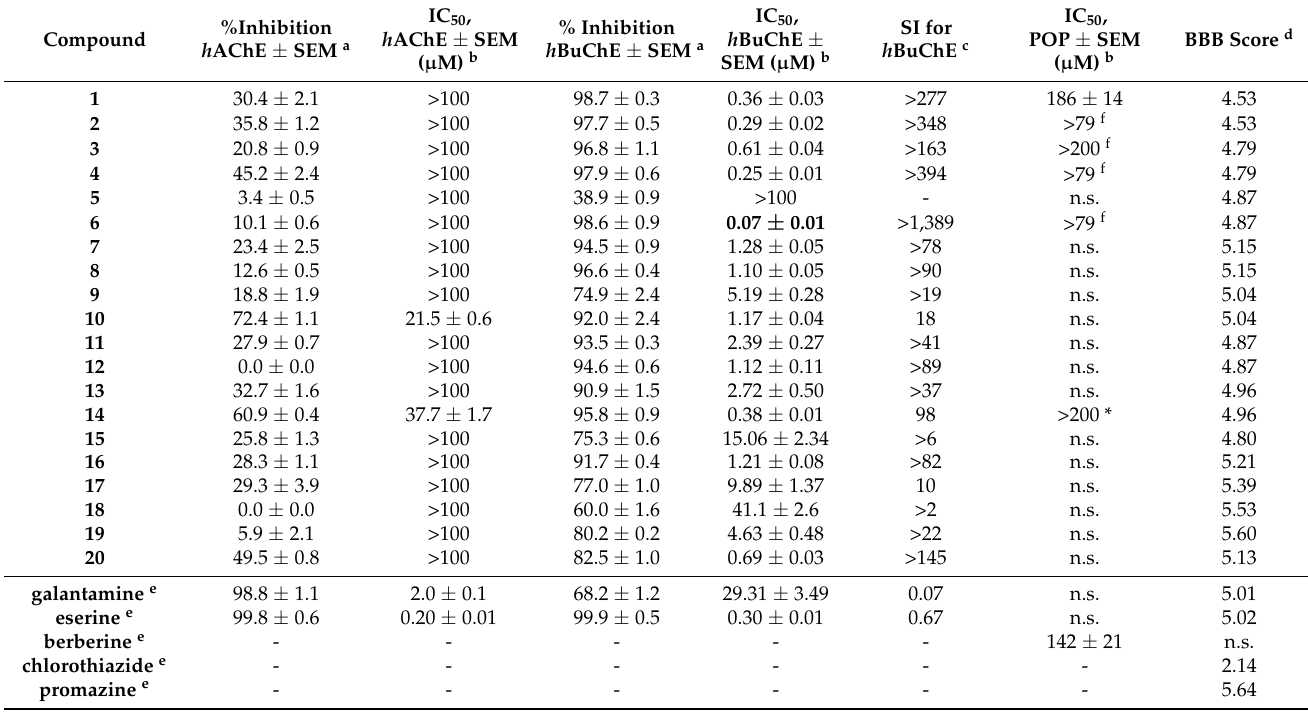
Table 1. In-vitro h AChE/ h BuChE, and POP inhibition by new derivatives ( 1 – 20 ) of norbelladine, and calculation of BBB score.